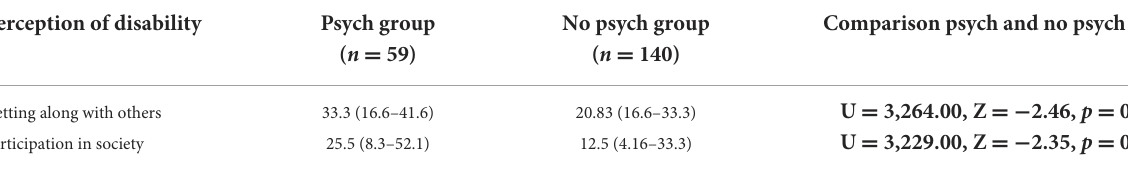
TABLE 2 Data concerning the perception of disability in two domains of the WHODAS 2.0 (median and interquartile range) and results of comparisons between groups (the Mann-Whitney U test). Perception of disability Comparison psych and no psych